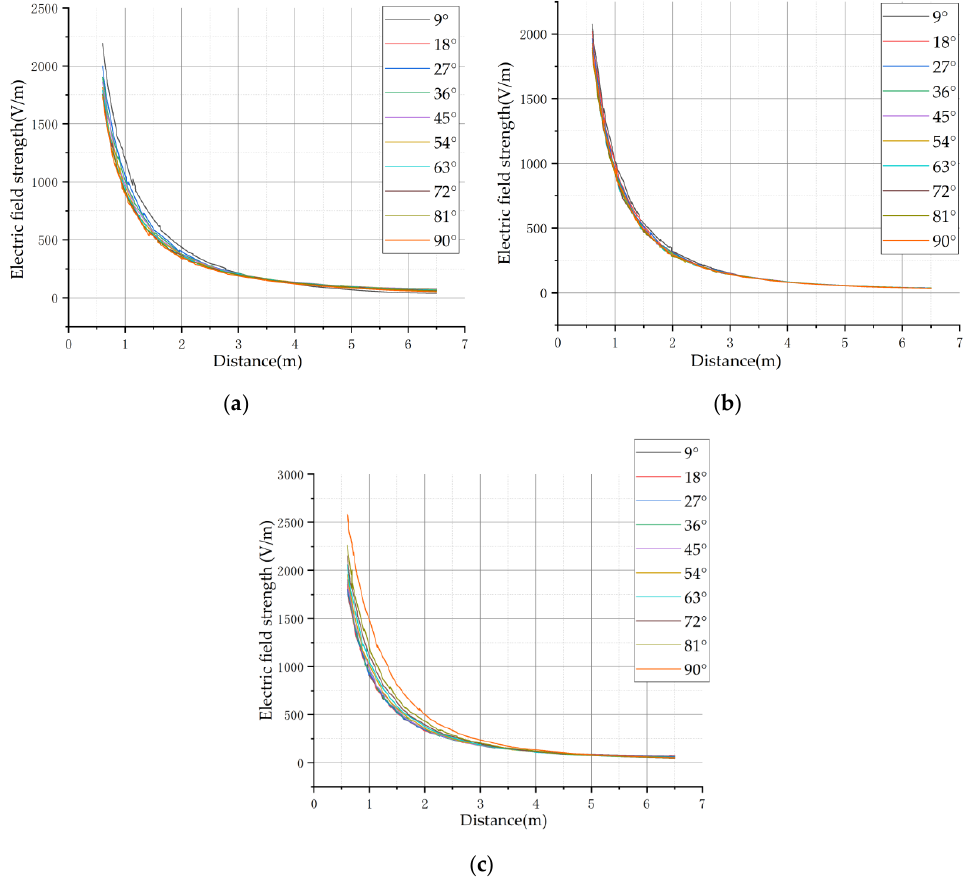
Figure 14. Electric field strength versus distance curves in the flight area of UAVs of different arrangements: ( a ) Horizontal arrangement; ( b ) Triangular arrangement; ( c ) Inverted triangular arrangement.